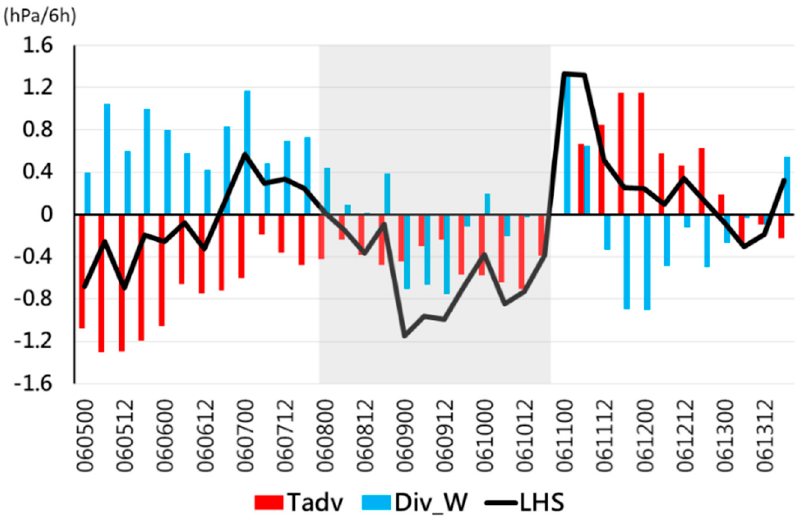
Figure 11. As in Figure 10, but showing the synoptic-scale signals of the pressure tendency (black), column-integrated density (thermal) advection (red bars), and the combined dynamic effect (blue bars, i.e., column-integrated convergence/divergence plus the mass transport by vertical motion. All units are in hPa per 6 h.